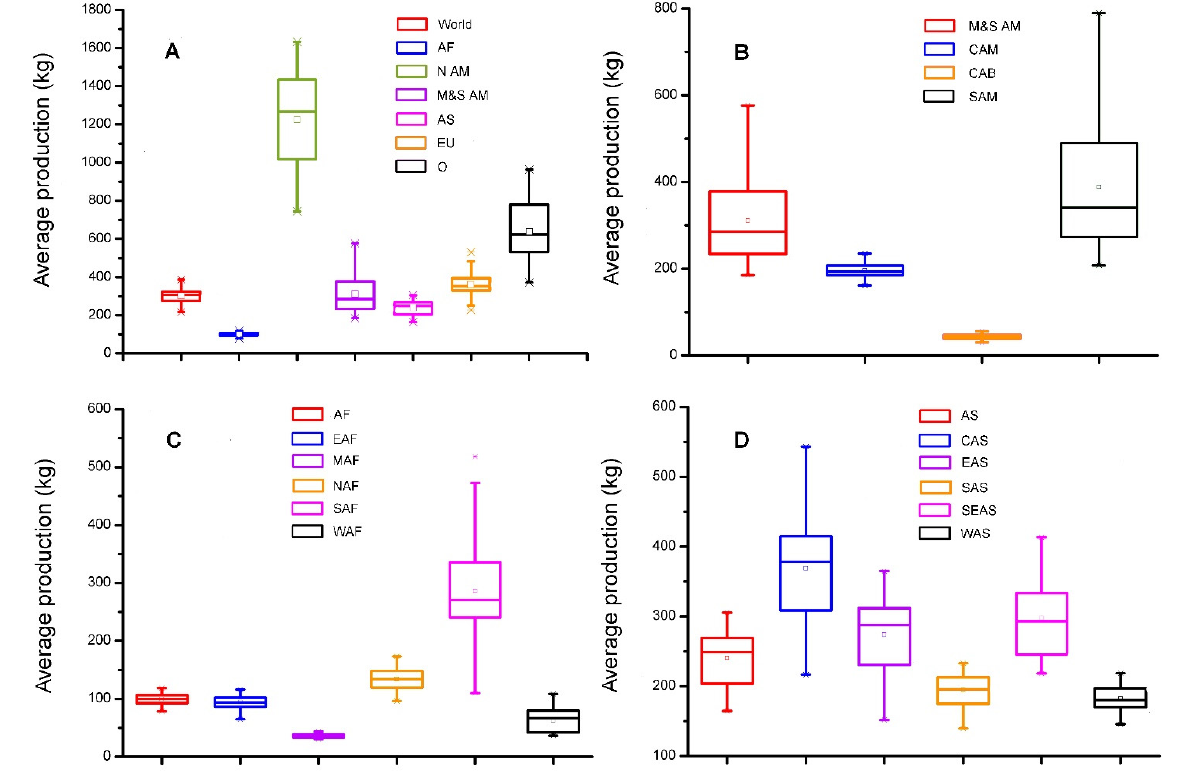
Figure 5. Comparisons on world average grain production over the past 55 years (1960–2014) at different continents ( A ), Mid and South America ( B ), Africa ( C ) and Asia ( D ). Abbreviations: AF, Africa; NAM, North America; M and S AM, Mid and South America; AS, Asia; EU, Europe; O, Oceania; CAM, Central America; CAB, Caribbean; SAM, South America; EAF, Eastern Africa; MAF, Mid-Africa; NAF, Northern Africa; SAF, Southern Africa; WAF, Western Africa; CAS, Central Asia; EAS, East Asia; SAS, Southern Asia; SEAS, South-east Asia; WAS, Western Asia.